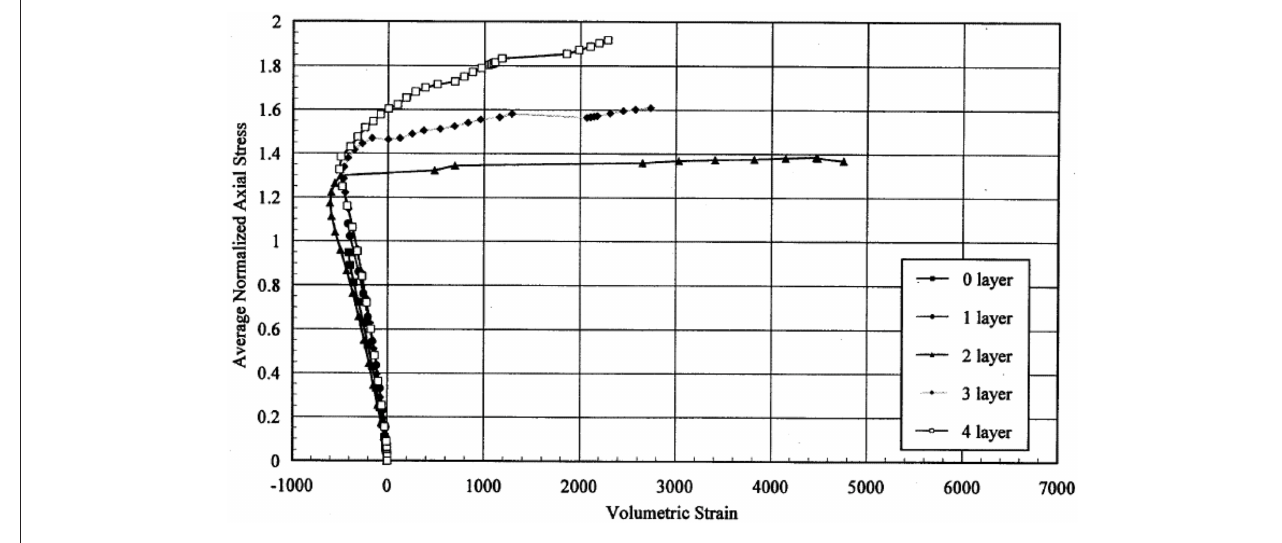
FIGURE 7 | Volumetric strain vs. axial stresses (Chaallal et al., 2000).